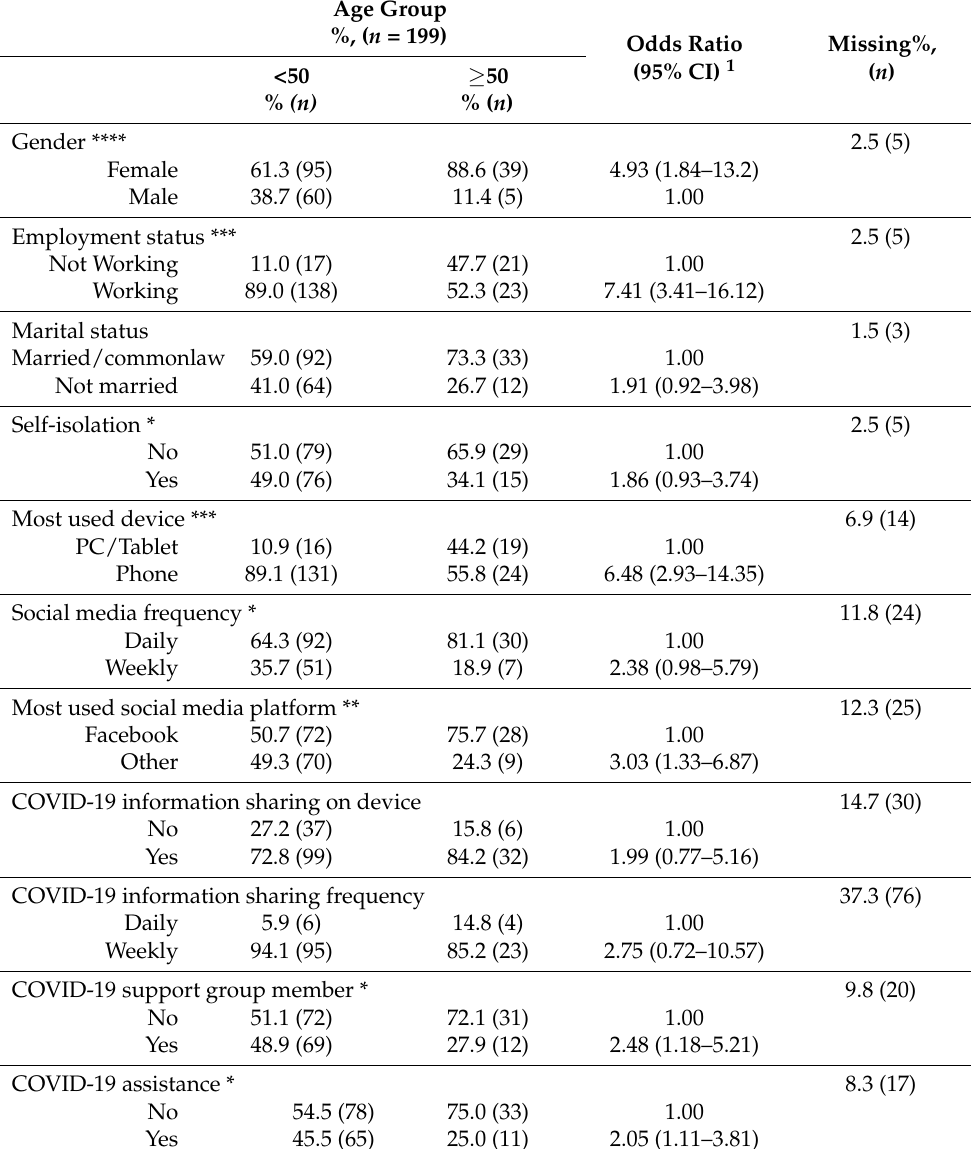
Table 2. Key variables stratified by age group ( n =